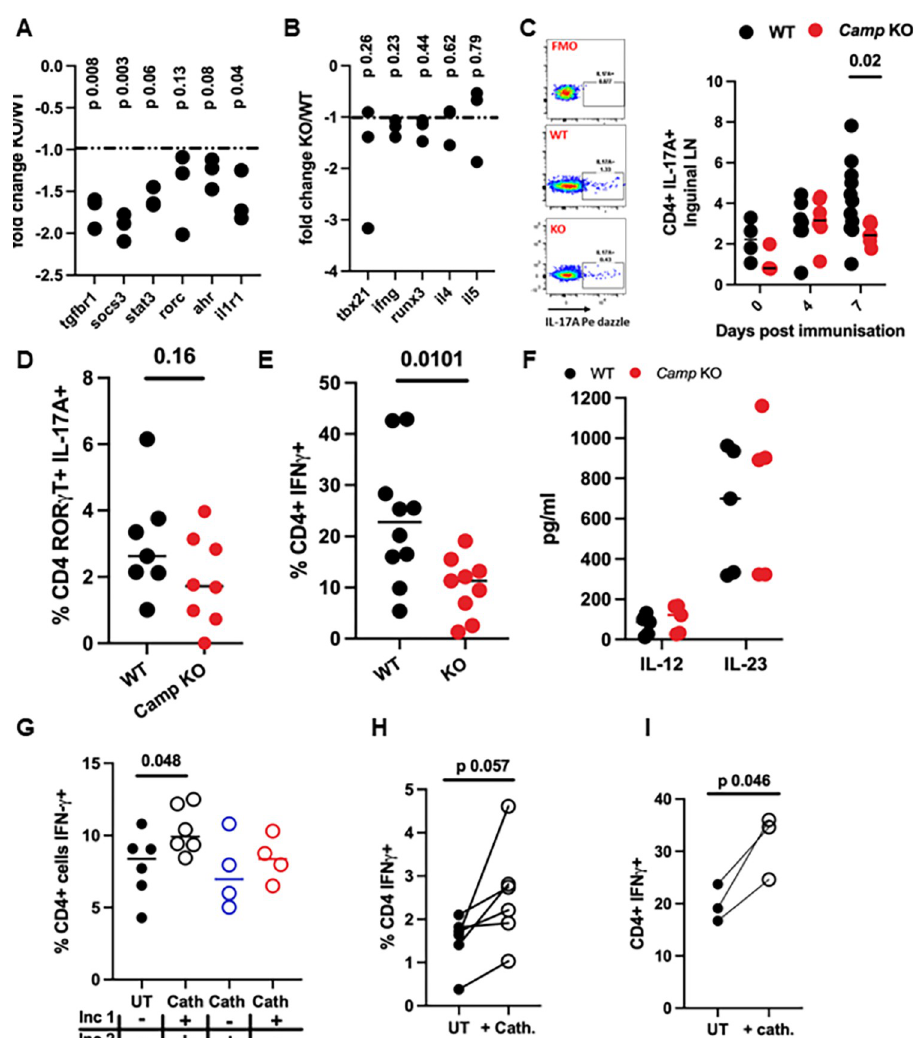
Fig 7. In the absence of cathelicidin T cell differentiation into Th17 cells and to exTh17 cells is impaired. EAE was induced in WT C57BL/6J and cathelicidin KO ( Camp−/− , KO) mice on day 0. On day 7, draining inguinal lymph nodes were removed and CD4 + T cells isolated. (A-B) Gene expression differences between WT and KO T cells were assessed on a Nanostring mouse immunology chip, and (C) on days 0, 4, and 7, IL-17 production was assessed by flow cytometry in the inguinal lymph nodes. (D, E) On day 14, cytokine production was assessed by flow cytometry or (F) by ELISA in the spinal cord. (G) WT splenic CD4 + T cells were cultured with Th17 driving medium for 48 hours (incubation 1, inc 1) then recombinant IL-12 for 72 hours (incubation 2, inc 2) before cytokine production was assessed by flow cytometry. (H) On day 7 of EAE inguinal lymph nodes were removed from WT mice and incubated for 72 hours with IL-12 and synthetic cathelicidin. (I) Human peripheral blood T cells were incubated with TGF- β and anti-CD3/CD28 stimulation then with IL-12 for 3 days, in the presence or absence of recombinant human cathelicidin (LL-37), after which IFN- γ was measured by flow cytometry. Data shown are individual data points with lines at median. N values: A, B– 3; C– 3–11; D– 7–8; E– 9–10; F– 5; G– 6 for UT and Cath ++, 4 for Cath − + and + − ; H– 6, I–3. Statistical tests used: (A, B)–two-tailed t tests with post hoc correction for multiple comparisons; (C)–two-tailed t test; (D, E)–two-tailed t test; (G, H, I)–paired two-tailed t test. Data available at 10.6084/m9.figshare.20310363. Cath, cathelicidin; EAE, experimental autoimmune encephalomyelitis; inc, incubation; KO, knockout; UT, untreated; WT,